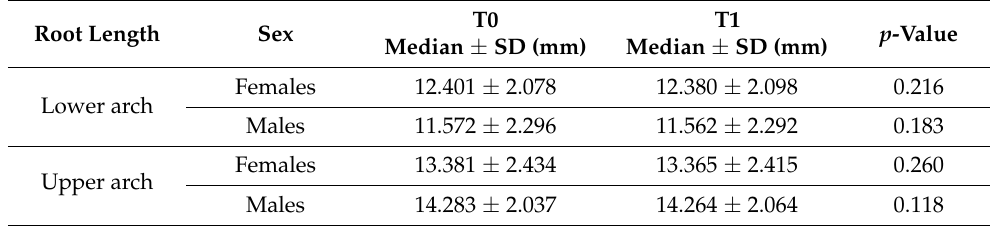
Table 6. Root length at T0 and T1 for maxillary and mandibular teeth in female and male